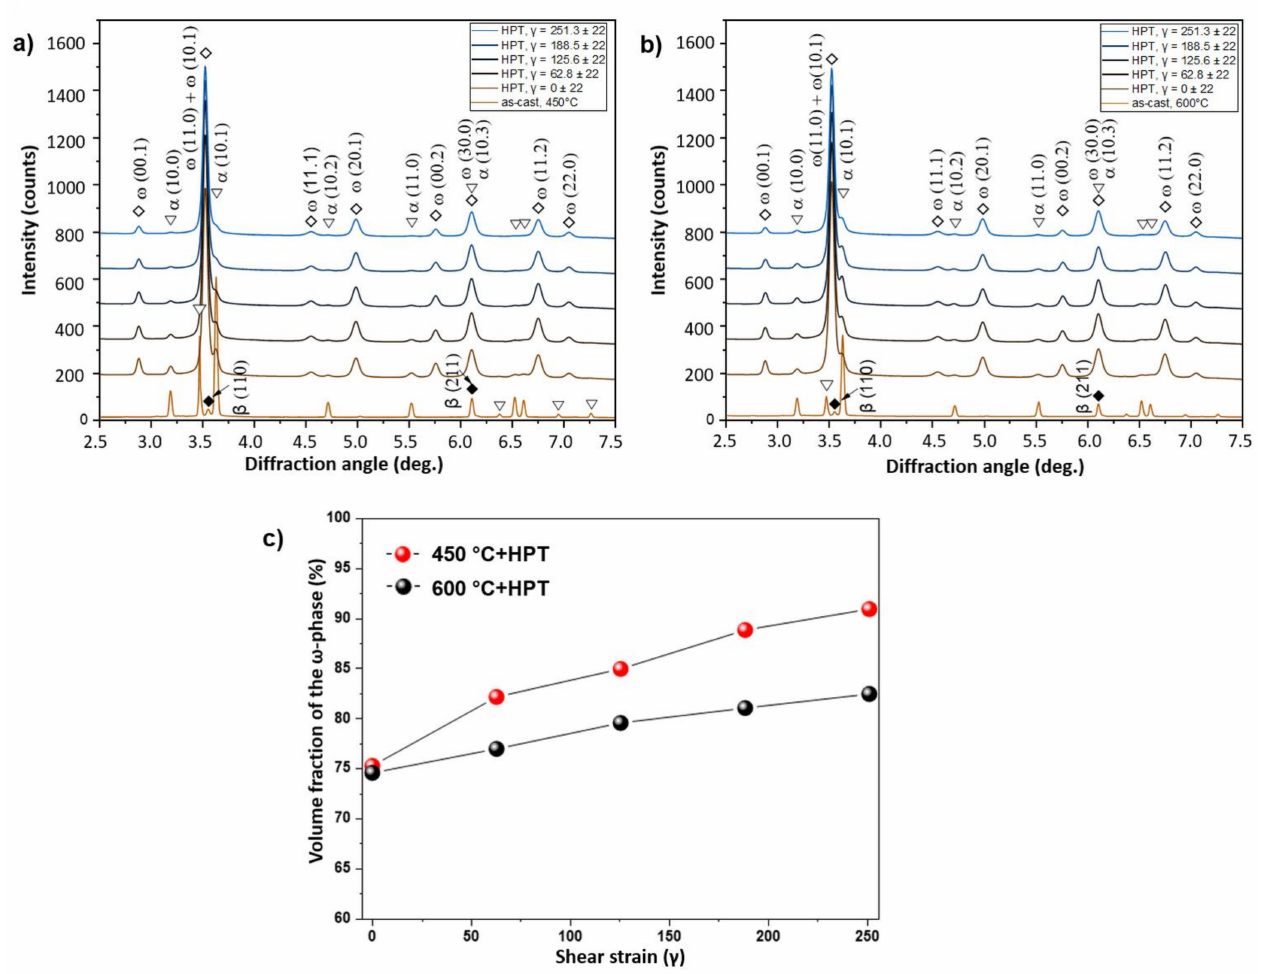
Figure 9. Synchrotron XRD curves of the deformed Ti–3wt.% Nb alloy, pre-annealed at 450 ◦ C ( a ) and 600 ◦ C ( b ). Volume fraction of the ω -phase as a function of the shear strain ( c